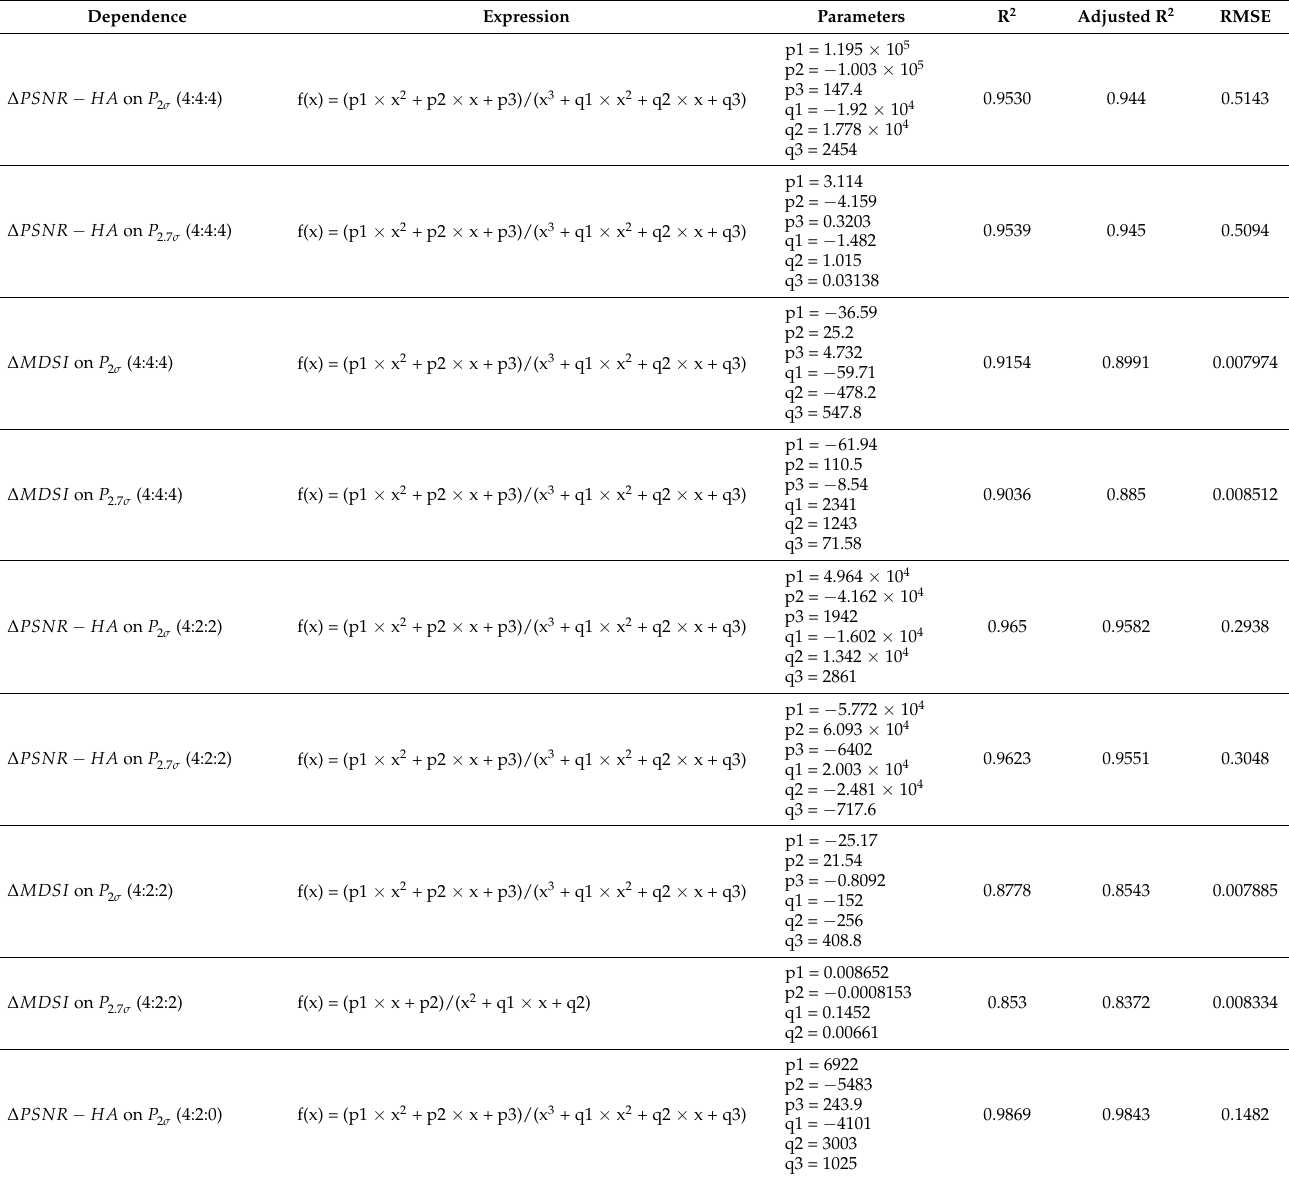
Table 1. Parameters of the fitted